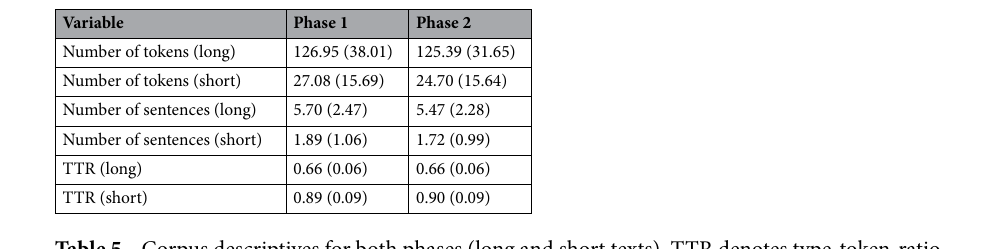
Table 5. Corpus descriptives for both phases (long and short texts). TTR denotes